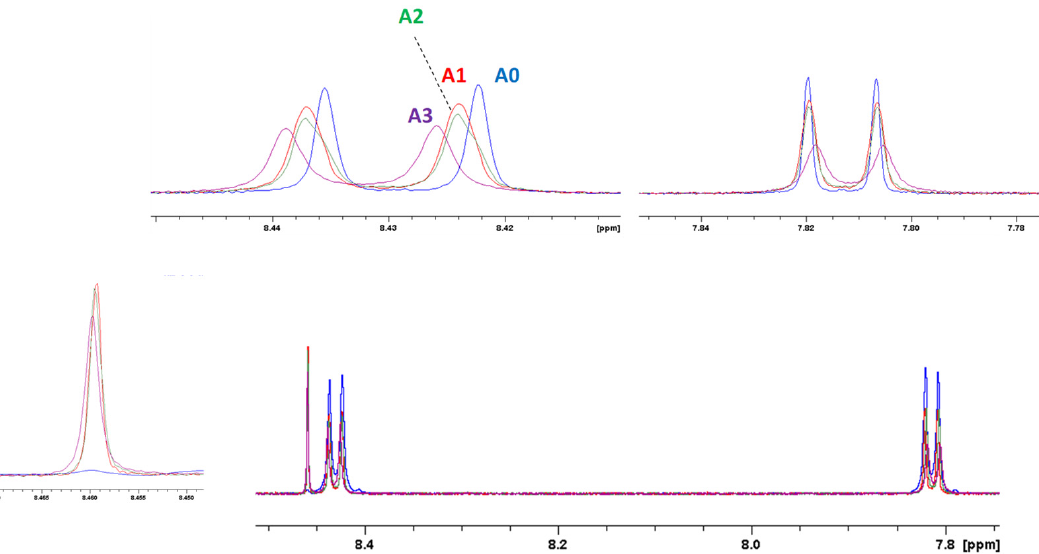
Figure 8. Concentration-dependent 1 H NMR spectra of PTAS at different Cu 2+ ion ratios in D 2 O at 298 K. A0: 30 μ M PTAS solution; A1: 30 μ M PTAS and 1 μ M Cu 2+ solution; A2: 30 μ M PTAS and 2 μ M Cu 2+ solution; A3: 30 μ M PTAS and 5 μ M Cu 2+ solution.